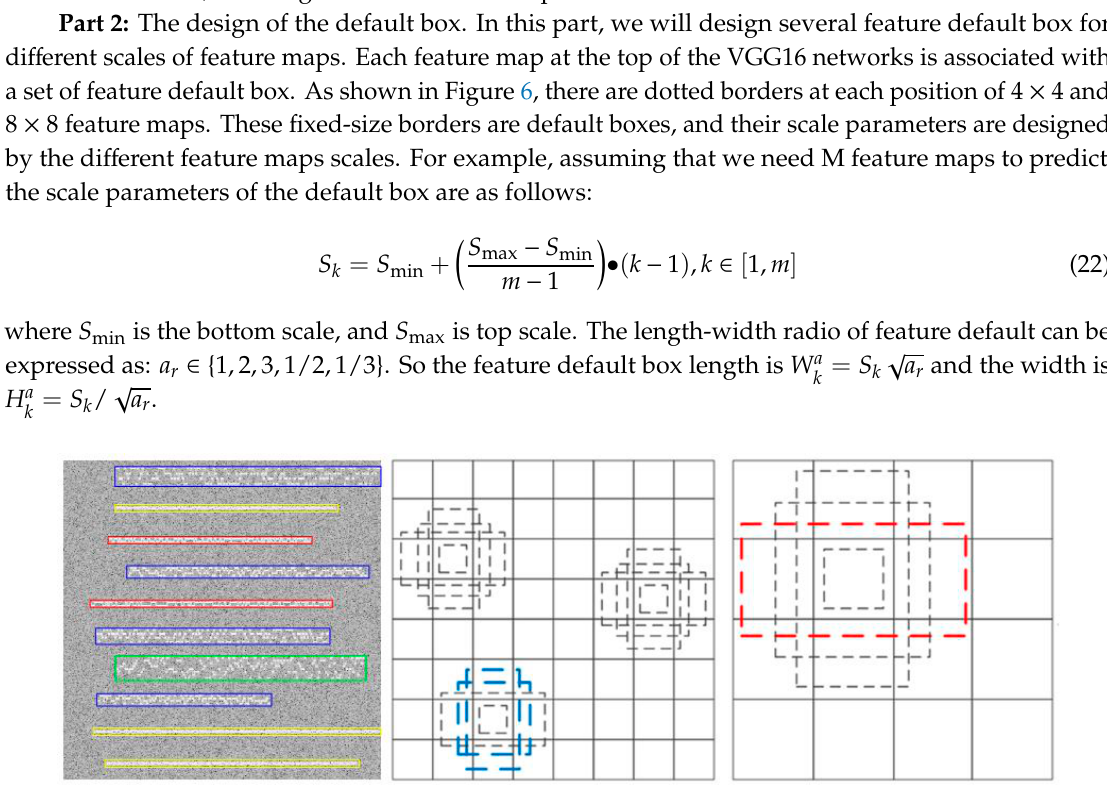
Figure 6. The Design of the default box.